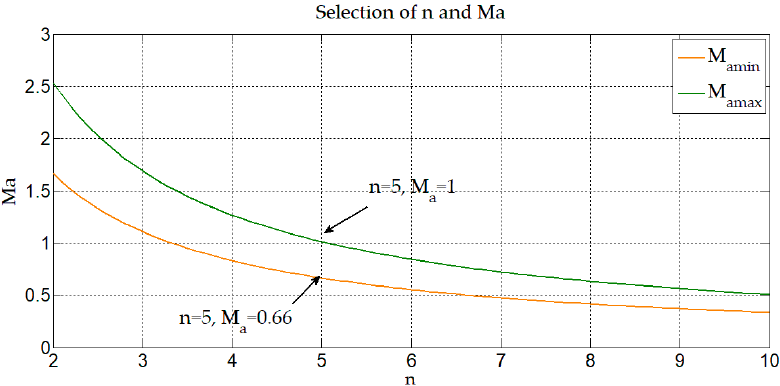
Figure 13. M amin and M amax obtained for different n .